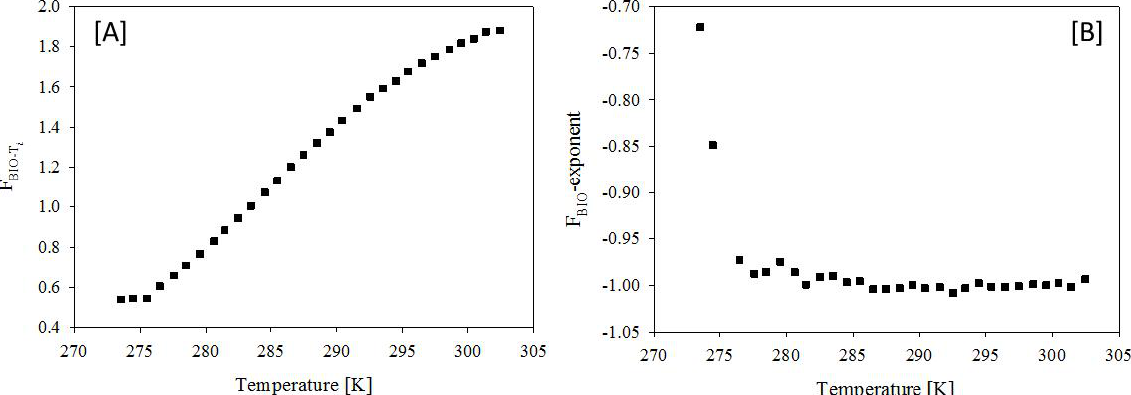
Fig. 8. Temperature dependent equation parameters for the exponential function relating the fraction of effective energy and mass transfer (EEMT) derived from primary production ( F BIO ) to EEMT in the from: F BIO - T =( F BIO - ref ) T EEMT C T . Both the reference F BIO (a) and the exponent (b) vary as a function of temperature.